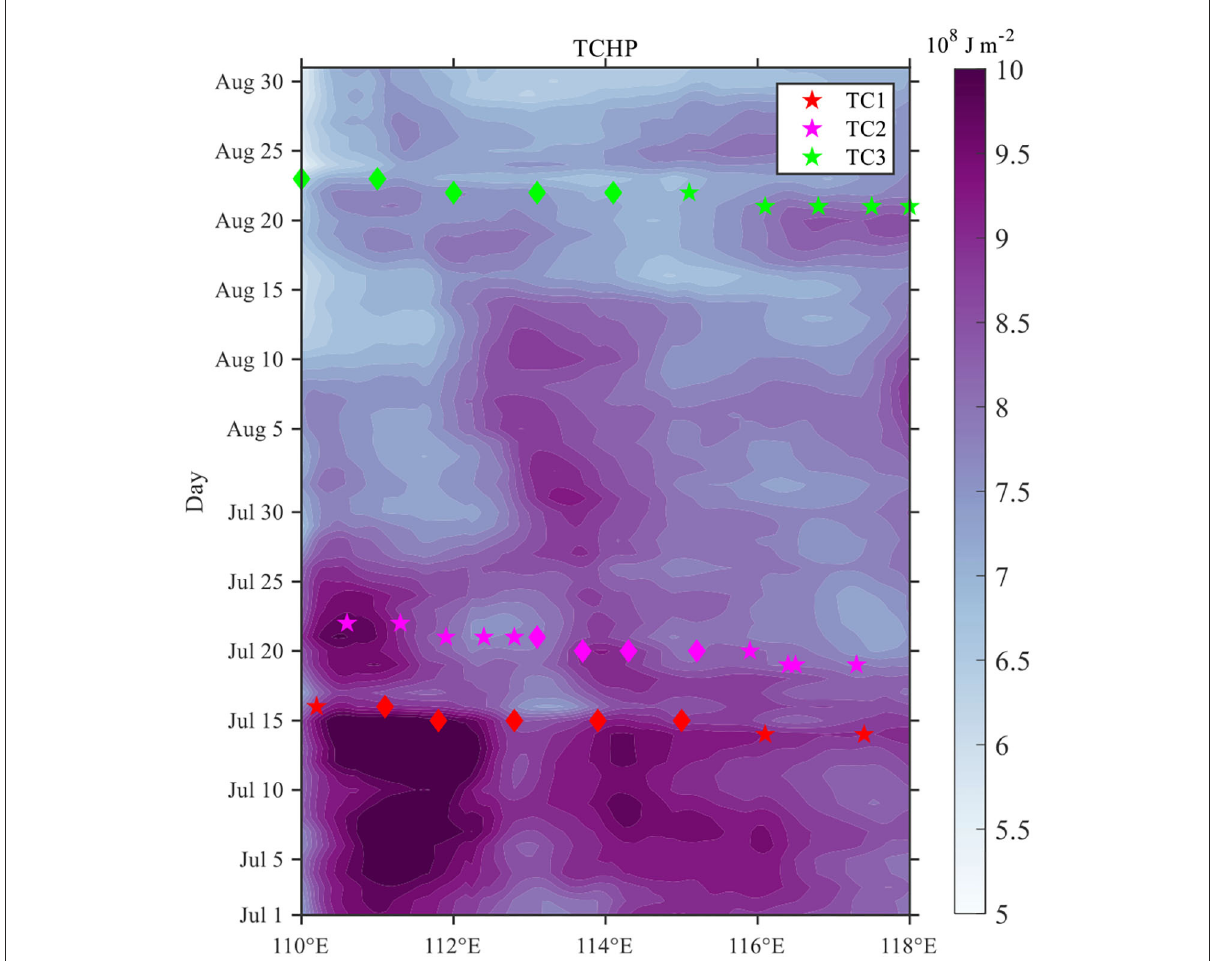
FIGURE5 Longitude-time series of TCHP (shading; units: J m − 2 ), averaged 12 ◦ N − 18 ◦ N. Red, purple, and green stars represent the zonal location of TC1/Conson, TC2/Chanthu, and TC3/Mindulle, respectively. Red, purple, and green diamonds represent the zonal location of TCs passing over the warm